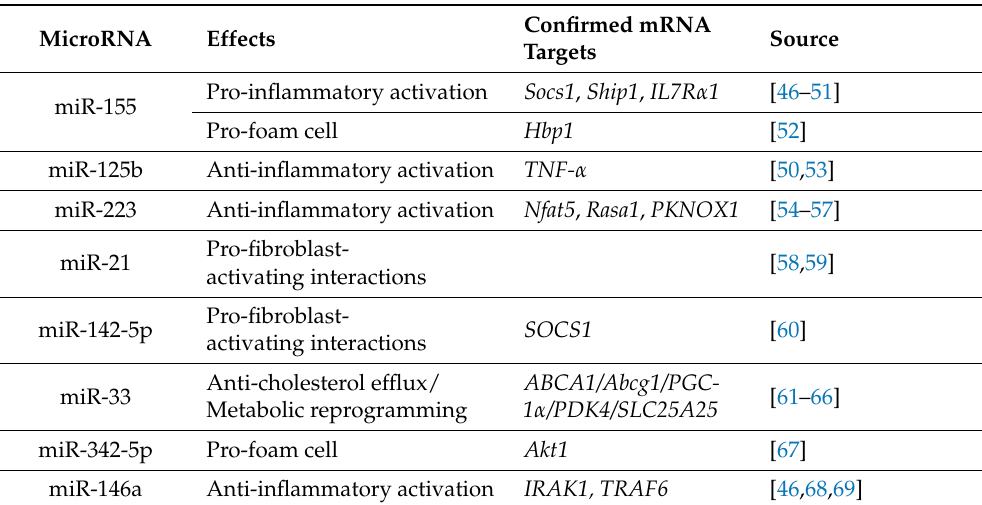
Table 1. MicroRNAs and confirmed mRNA targets that regulate macrophage functions important to AT